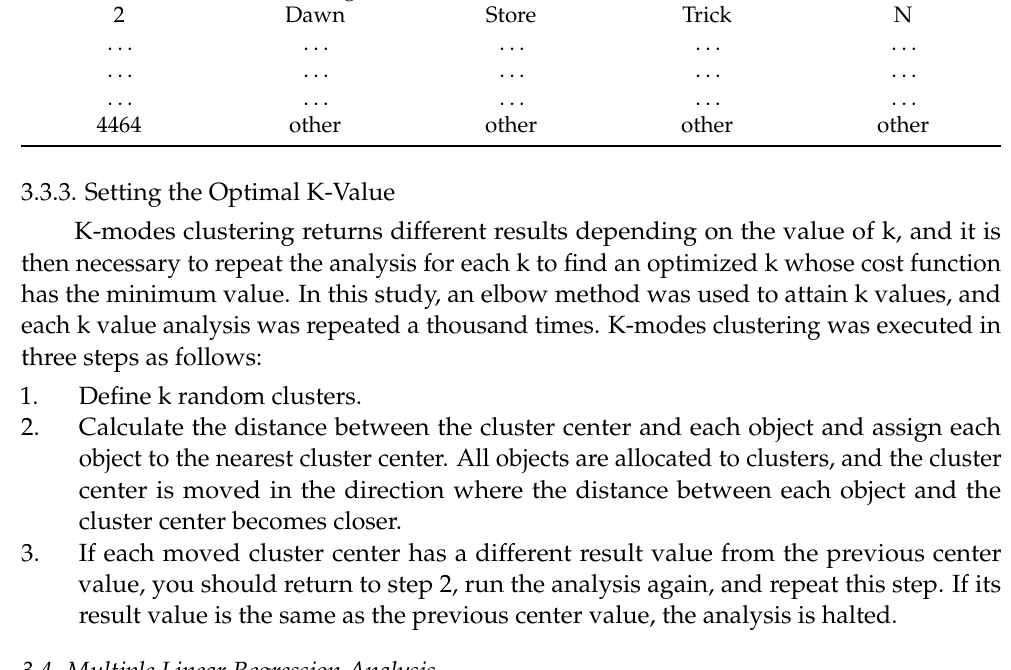
Location Method Classification